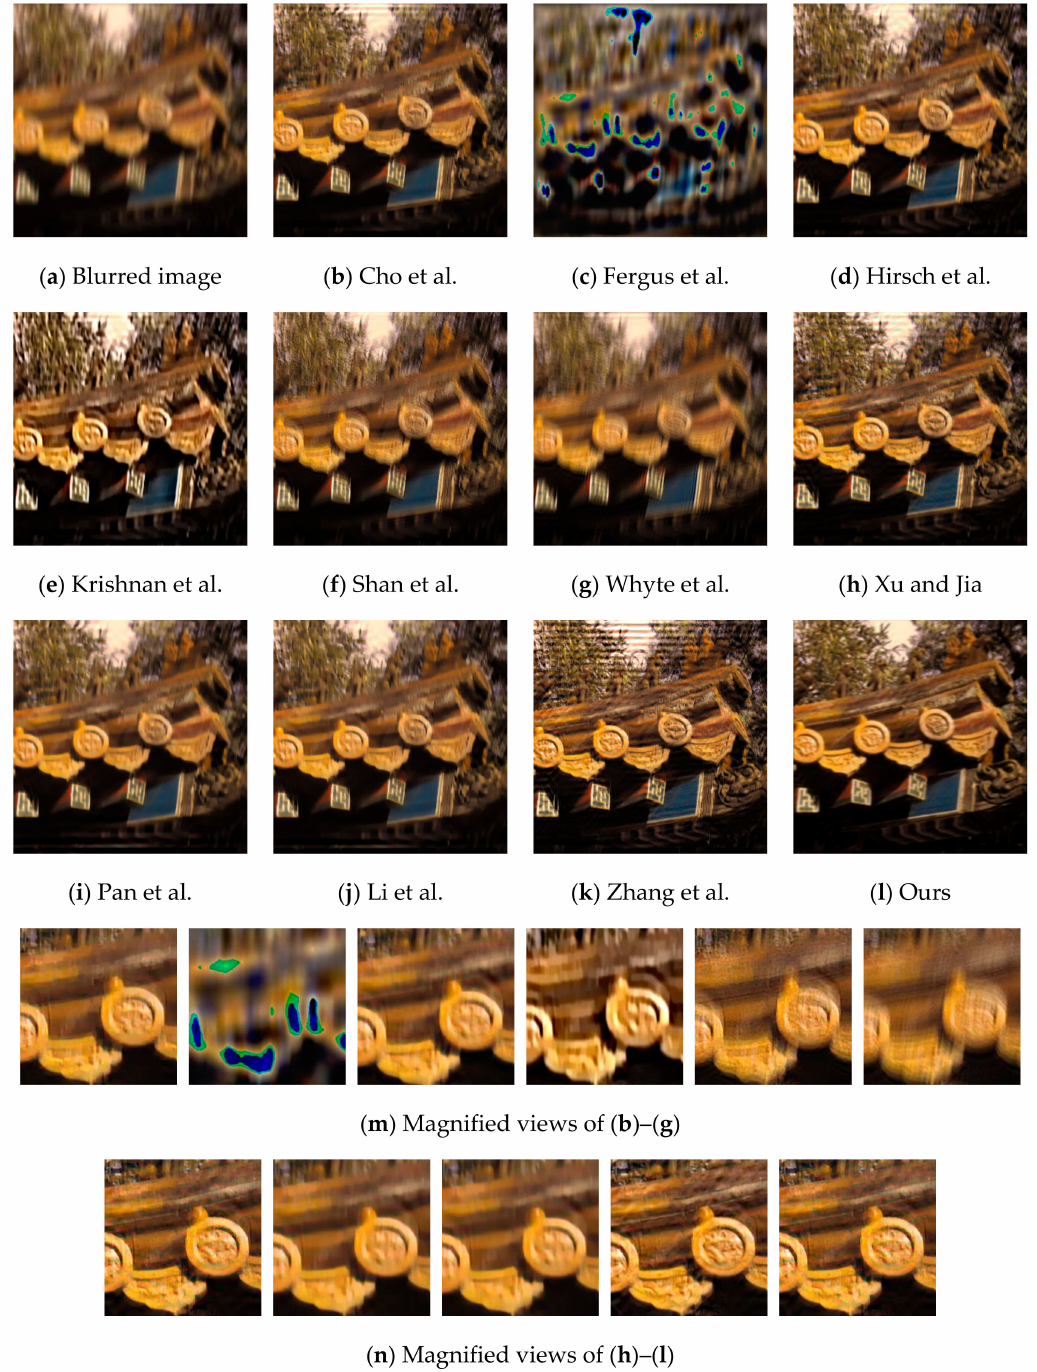
Figure 9. Image deblurring results on the dataset of Köhler et